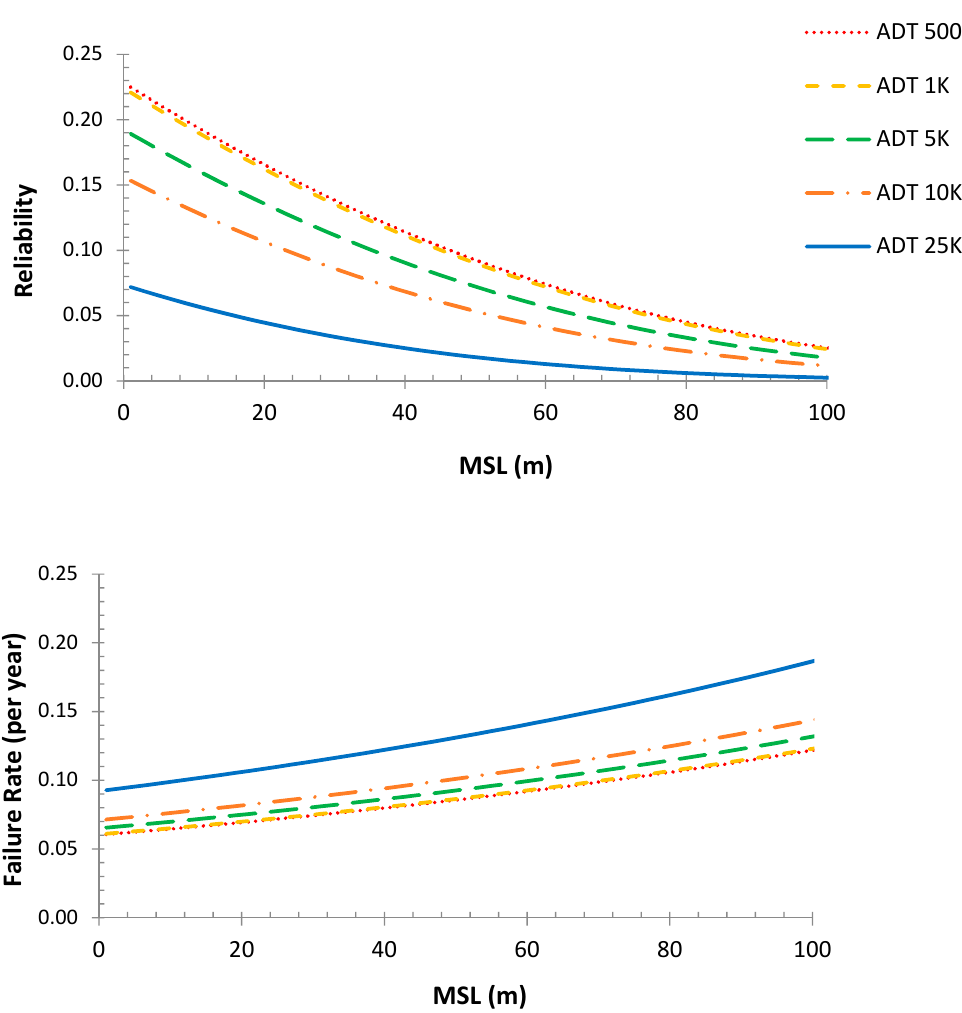
Figure 7. Superstructure reliability and hazard rate versus MSL with different ADT values at the age of 75 years (All superstructure types).